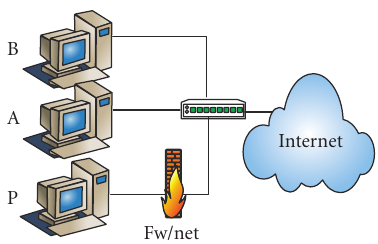
Figure 1: Pathwise metrics: active testbed